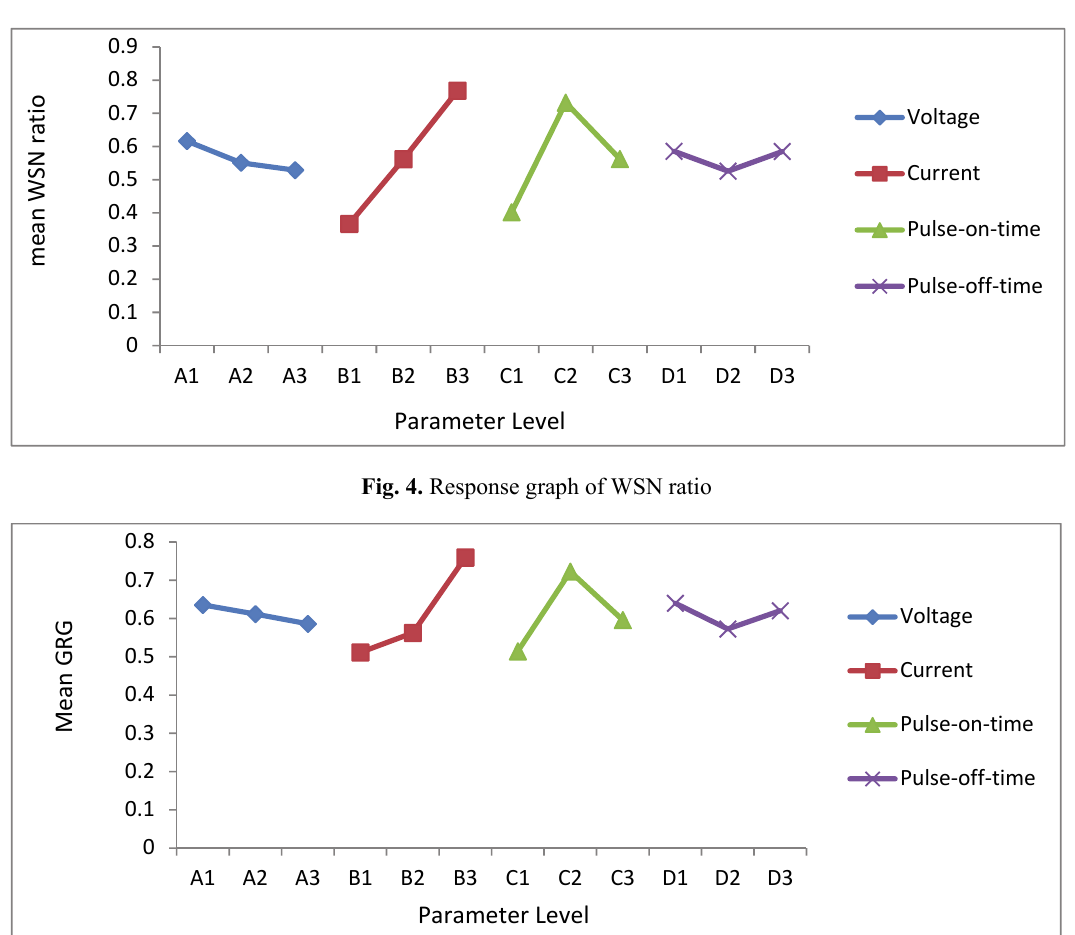
Fig. 5. Response graph of grey relational grade